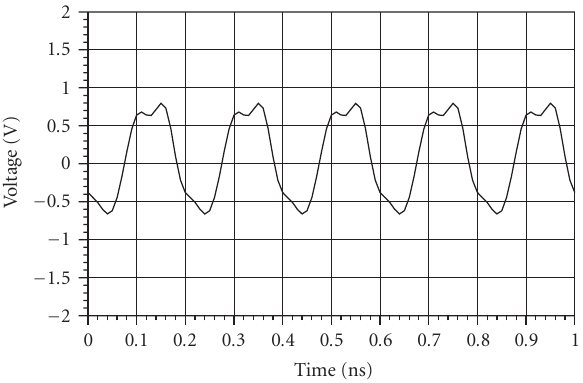
Figure 8: Reconstructed waveform using only 5 lowest output